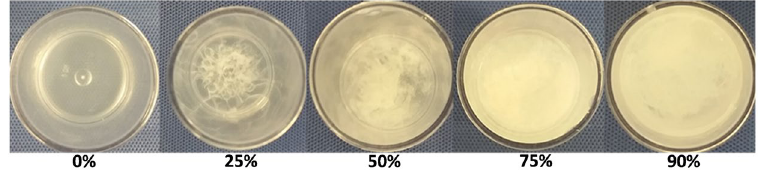
Figure 2. Ethyl cellulose-ethanol forms a gel upon exposure to water. A 3% ethyl cellulose-ethanol solution either alone (0%) or in solution with 20%, 50%, 75% or 90% water.